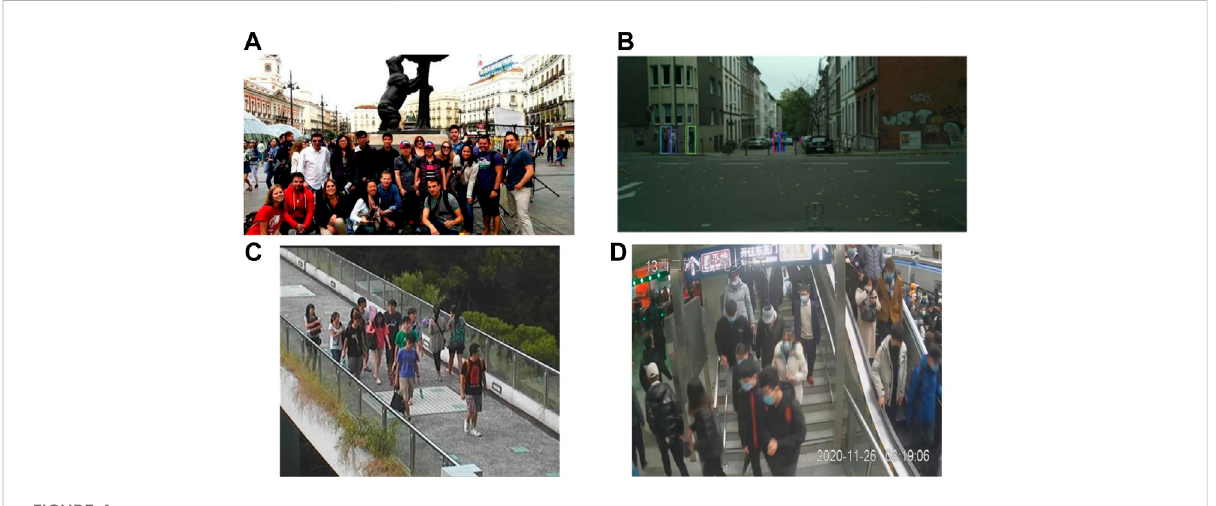
FIGURE 4 Comparison of MetroStation with other pedestrian detection datasets. (A) CrowdHuman, (B) CityPerson, (C) CUHK occlusion, and (D) MetroStation.